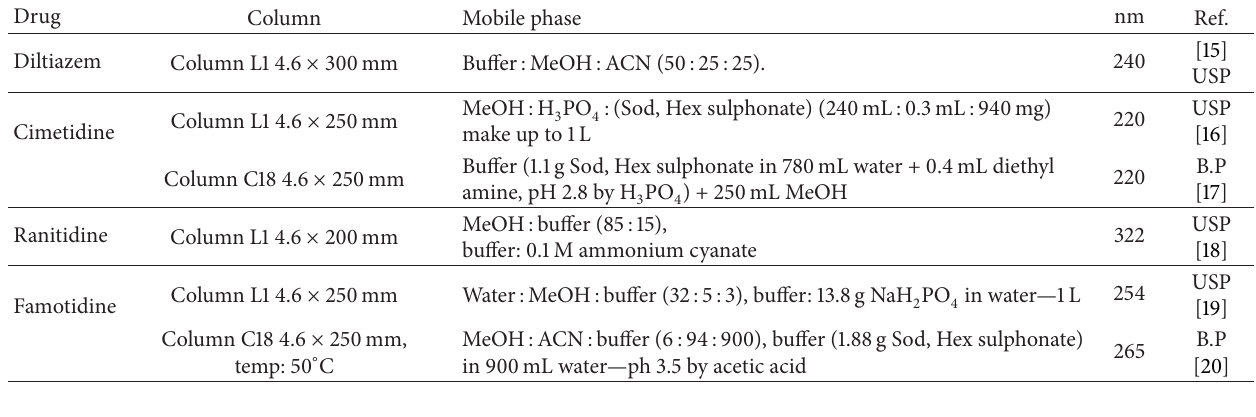
Figure 3: Ranitidine.